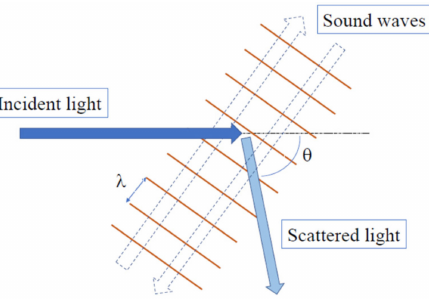
Figure 1. Brillouin scattering process among the incident and scattered light and periodically modu- lation of the density by thermally excited sound waves, where λ and θ are the wavelength of sound waves and scattering angle,